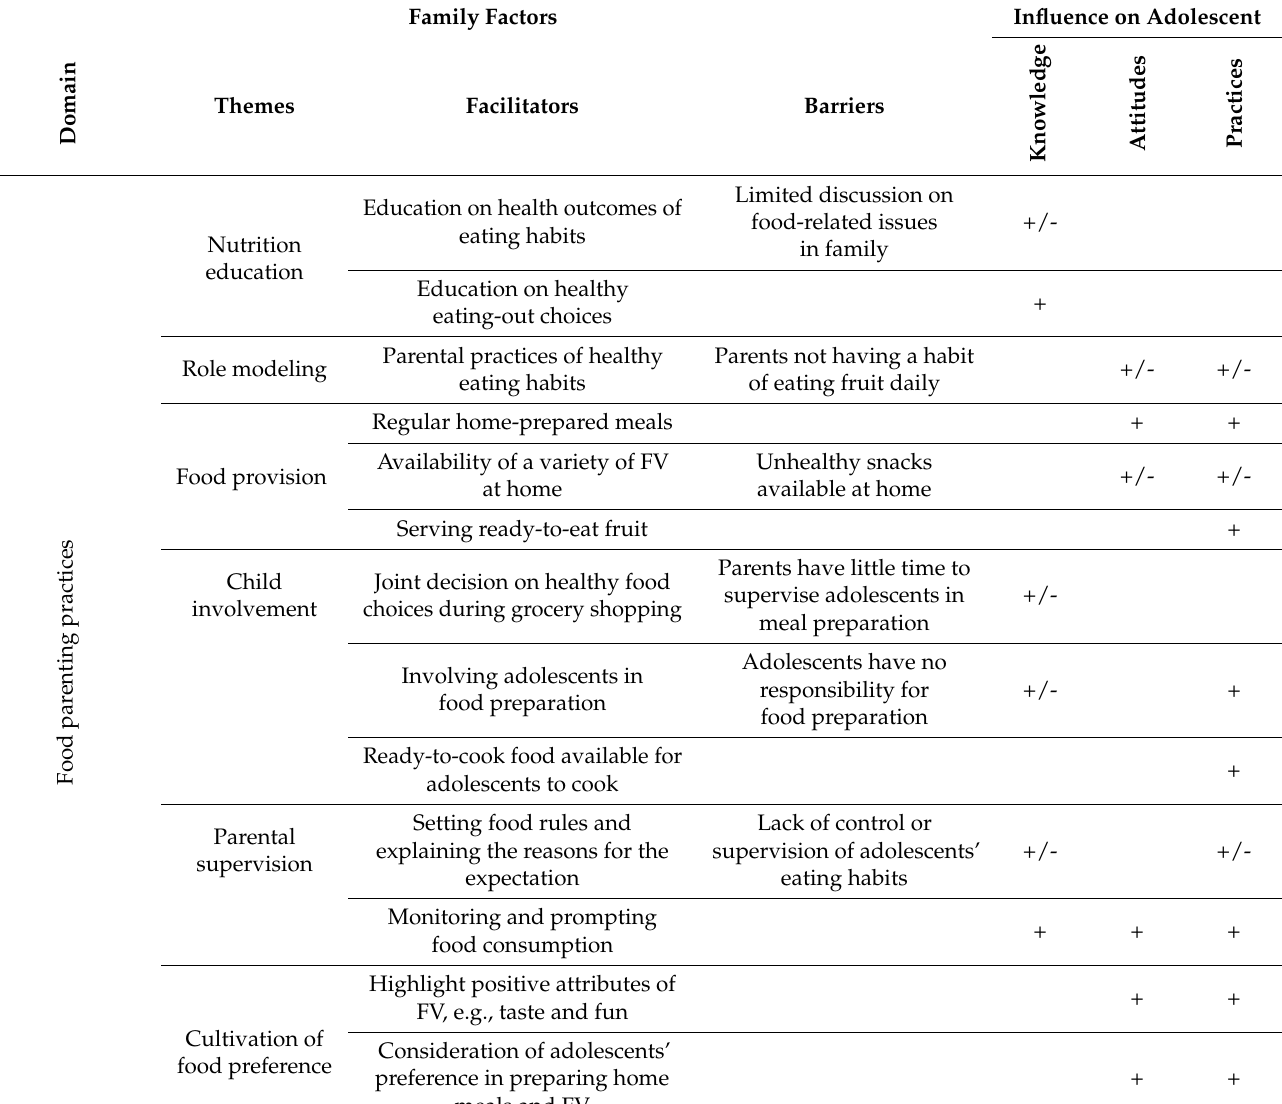
Table 4. Influence of food parenting practices on adolescent KAP of healthy